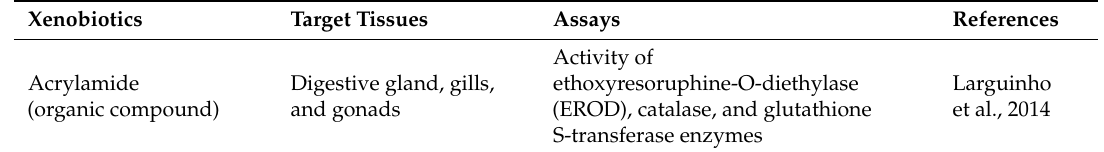
Table 1. List of pollutants that have been tested, with the organs analyzed for each substance and the type of analysis carried out on Mytilus galloprovincialis